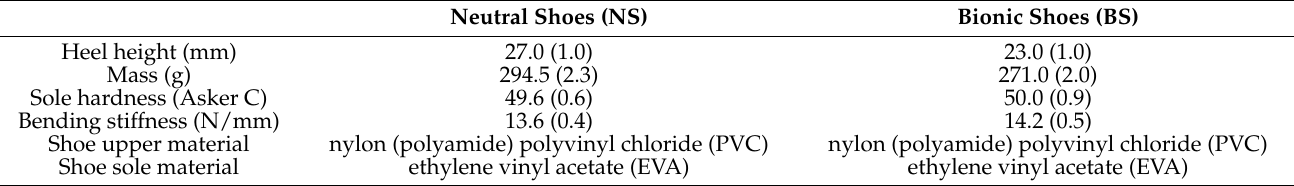
Figure 1. Illustration of bionic shoe-making procedure and neutral shoes [25]. Table 1. Information about characteristics and materials of the tested